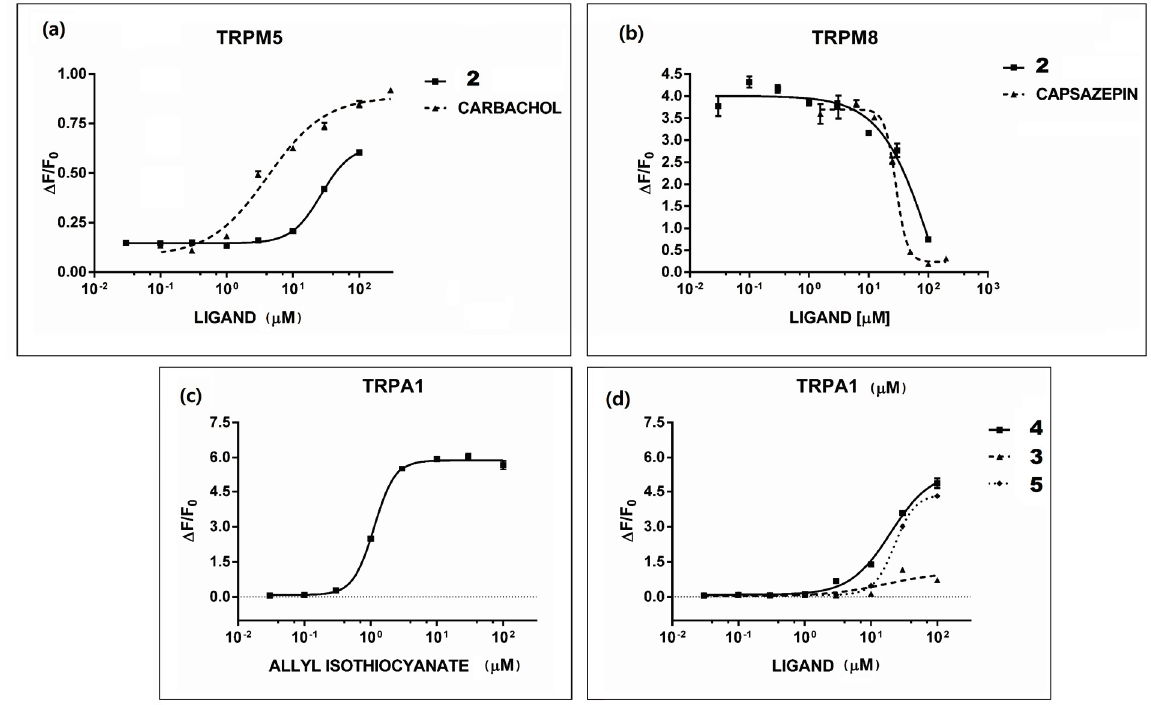
Figure 3. In vitro assays with TRP channels. Each dose/response curve was performed at least three times using replicates ( n = 4). In vitro activity of rutamarin 2 and its reference compound capsazepine on ( a ) TRPM5 and ( b ) TRPM8. In vitro activity on TRPA1 of ( c ) the reference compound allyl isothiocyanate and ( d ) Compounds 3 , 4 and 5